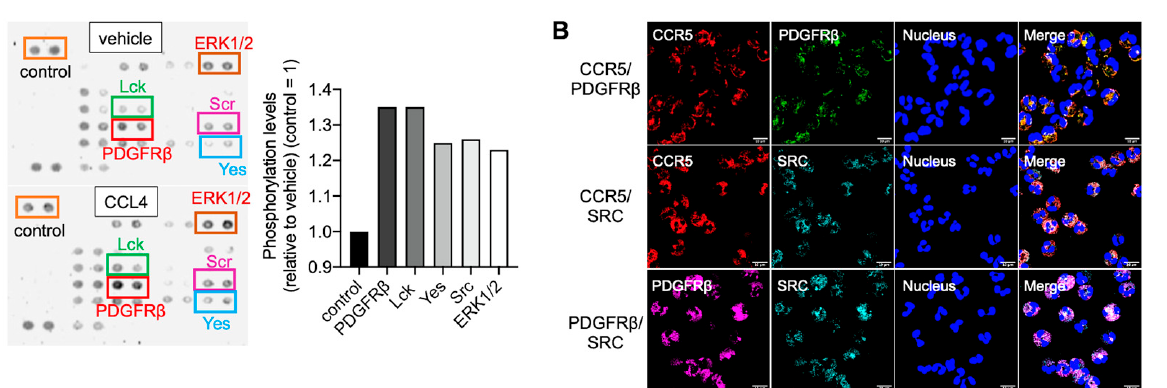
Figure 4. CCL4-mediated eosinophil activation signaling. ( A ) Phosphorylation levels of multiple kinases in eosinophils. Purified peripheral blood eosinophils were treated with CCL4 (10 μ g/mL) for 5 min using a Human Phospho-Kinase Antibody Array Kit (R&D). Phosphorylation levels of platelet-derived growth factor receptor (PDGFR) β , Src kinase family (Lck, Src, and Yes), extracellu- lar signal-regulated kinase (ERK), and control are presented as dots (left panel) or a relative value to vehicle (right panel). ( B ) Colocalization of CCR5, PDGFR β , and Src in eosinophils. CCR5 (red), PDGFR β (green or pink), Src (light blue), and the nucleus (blue) are shown. Images were obtained using an FV3000 confocal microscope (600 × objectives). The scale bars in the bottom-right corner indicate 10 μ m. The results are representative of at least three experiments. ( C ) Purified peripheral blood eosinophils were pretreated with imatinib—a PDGFR β inhibitor (I, 5 μ M) —and/or da- satinib—a Src inhibitor (D, 10 nM) —for 30 min, followed by overnight incubation with CCL4 (10 μ g/mL). CD69 expression in eosinophils was determined [(i) percentage of CD69+ Siglec-8+ double- positive cells and (ii) CD69 median fluorescence intensity (MFI) ratio to isotype control]. The values represent the mean ± SEM of four experiments. # p < 0.05 (vs. nontreatment control); * p < 0.05 (be- tween the two groups).